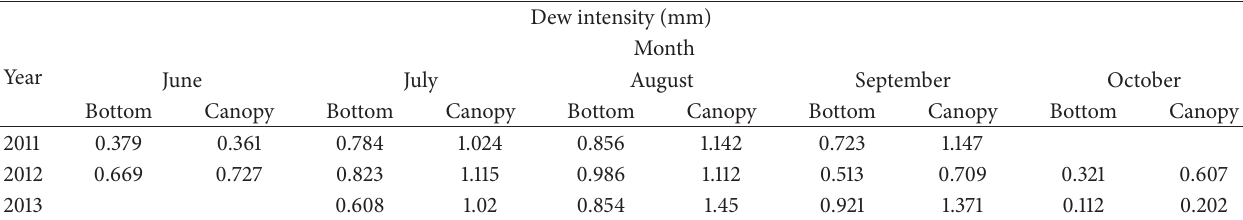
Table 7: Monthly total dew intensity of bottom and canopy in